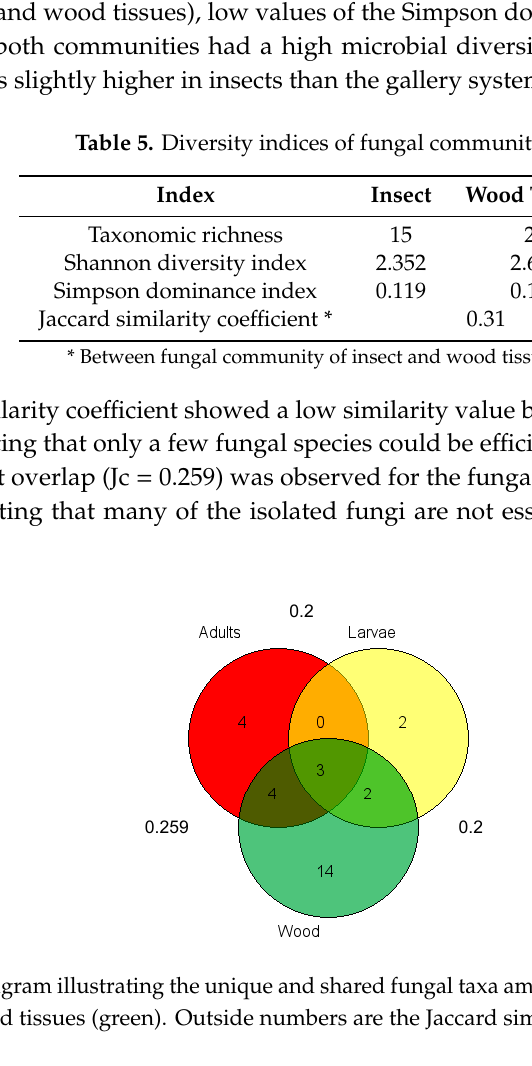
Table 5. Diversity indices of fungal communities.